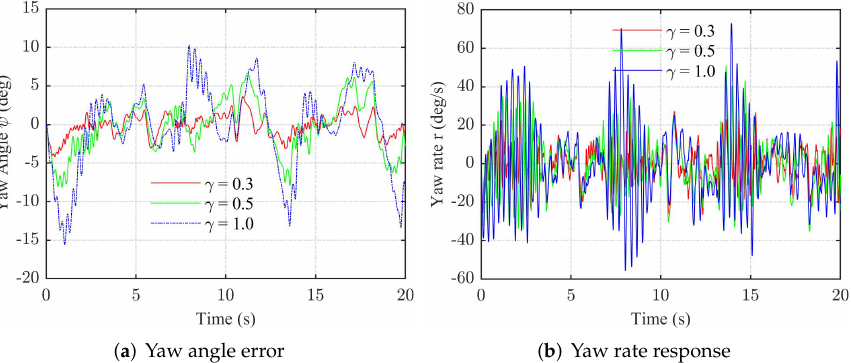
Figure 14. Performance of disturbance attenuation index γ